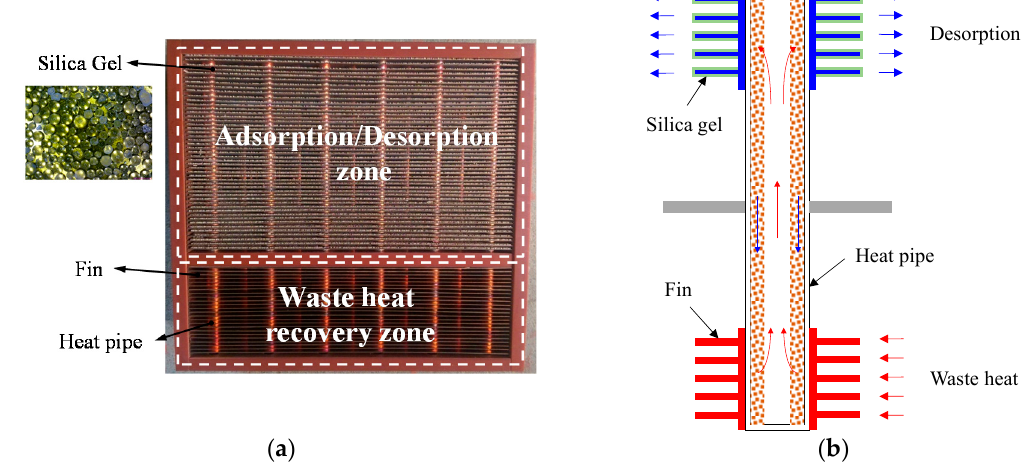
Figure 1. The schematic diagram of the ( a ) front view of the heat pipe-based desiccant device, and ( b ) one of the plate fins.